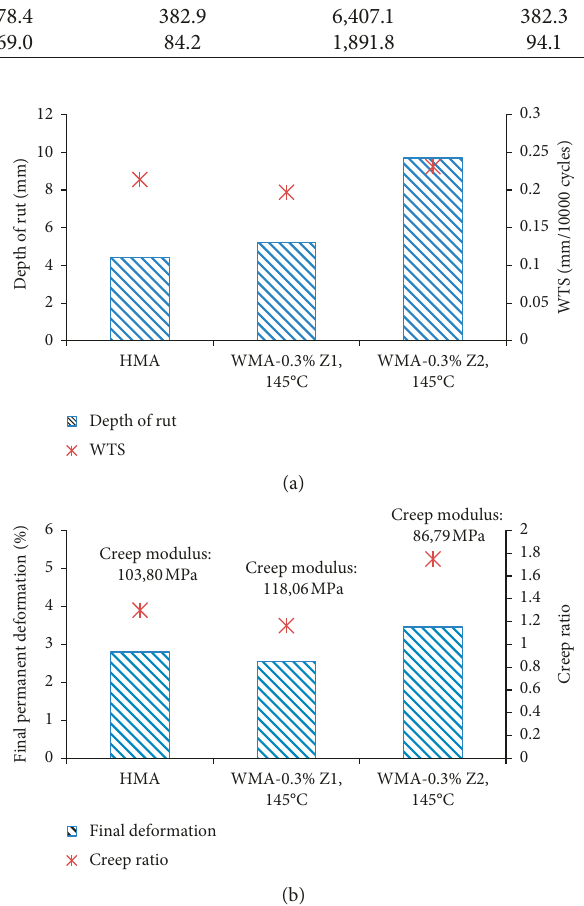
Figure 8: Resistance to plastic deformations measured by the wheel tracking test (a) and the triaxial test (b).